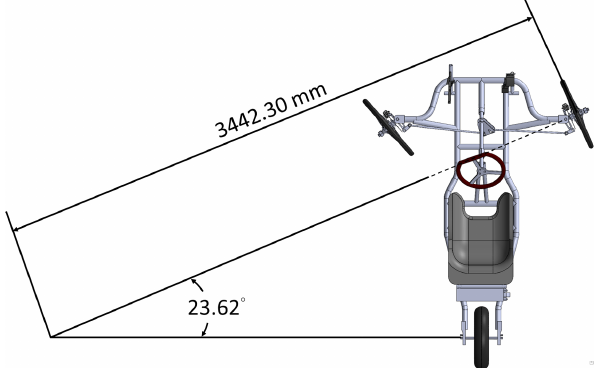
Figure 5. Schematic diagram of the maximum cornering angle and minimum turning radius.